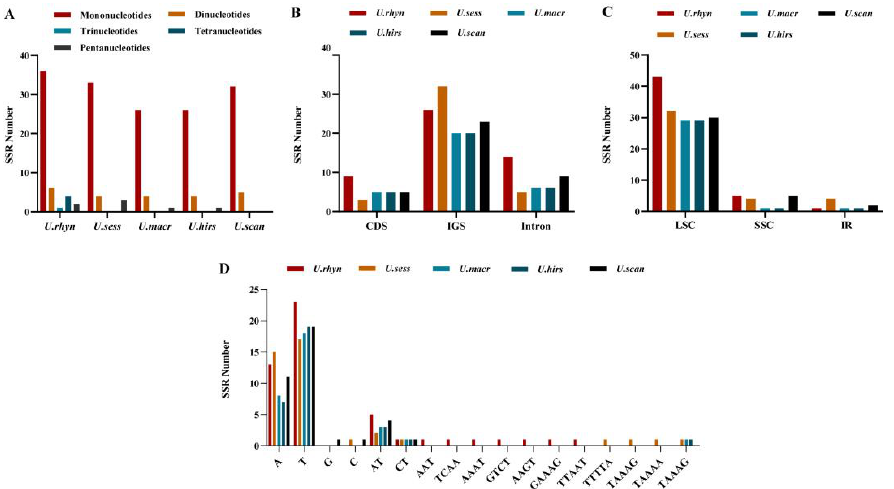
Figure 7. SSR analyses for five Uncaria species in cp genomes. ( A ) Number of different SSR types; ( B ) Frequency of identified SSRs in LSC, SSC, and IR regions; ( C ) Frequency of identified SSRs in CDS, IGS (intergenic spacer region), and intron; ( D ) Frequency of identified SSR in different repeat class types.